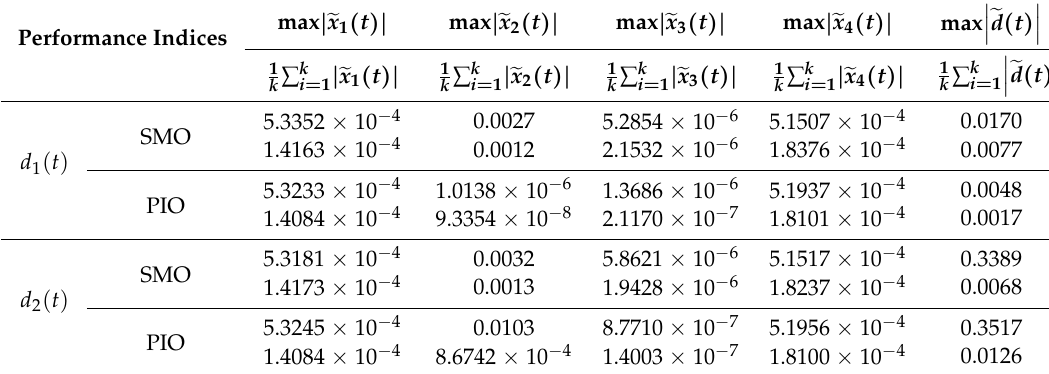
Table 2. Observation precision comparison ( t ≥ 6